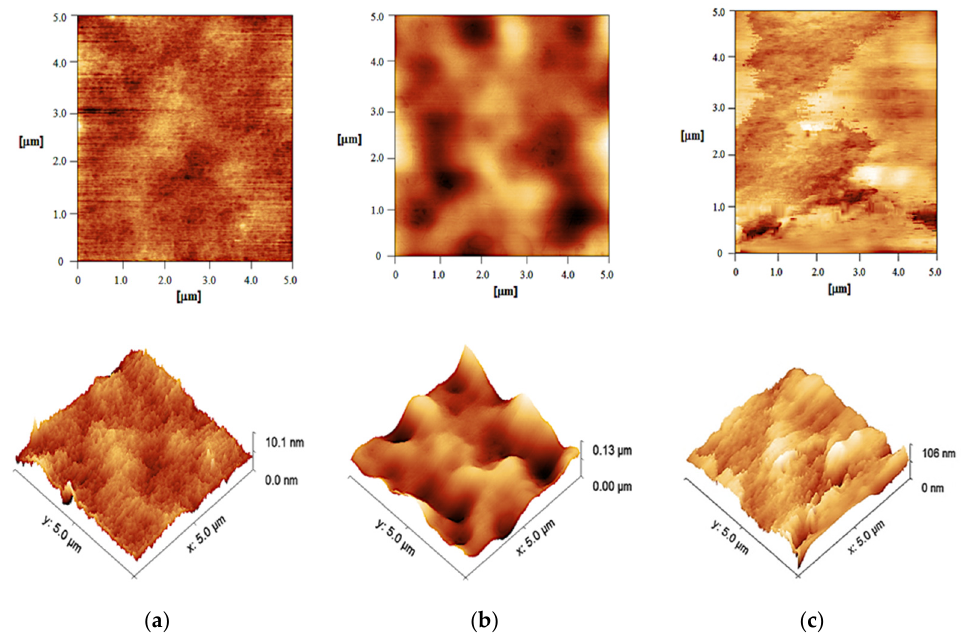
Figure 3. Comparative view of 2D (upper images) vs. 3D (lower) AFM images obtained by scanning the 5 × 5 μ m 2 film surface generated by the samples: ( a ) S1A, ( b ) S2A and ( c ) S3A.